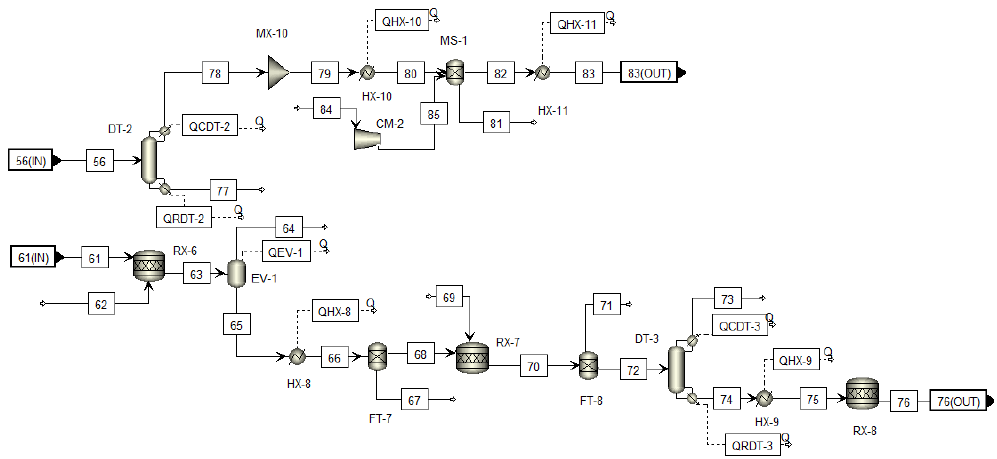
Figure 11. Purification stage flowsheet in topology 2.